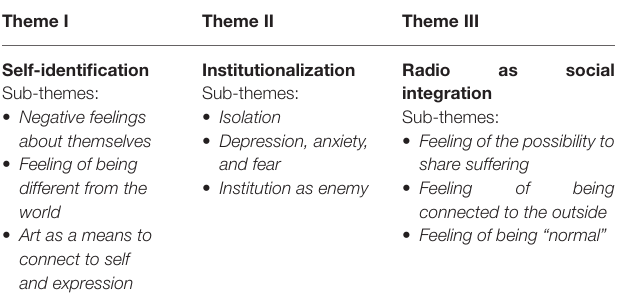
TABLE 1 | Themes emerged from in-patients testimonies on radio program. Theme I